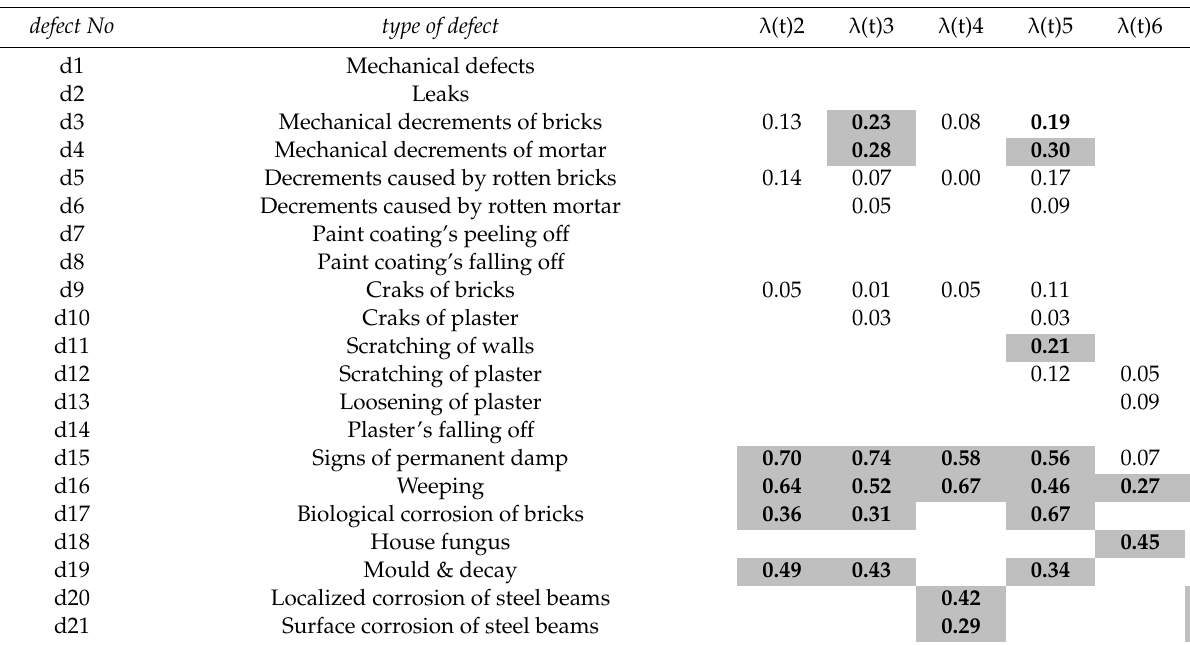
Average Values of Intensity Defects Formation for 10 Selected Most Critical Elements of Residential